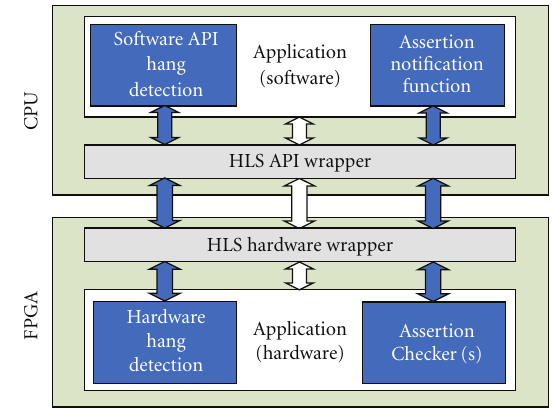
Figure 1: Assertion